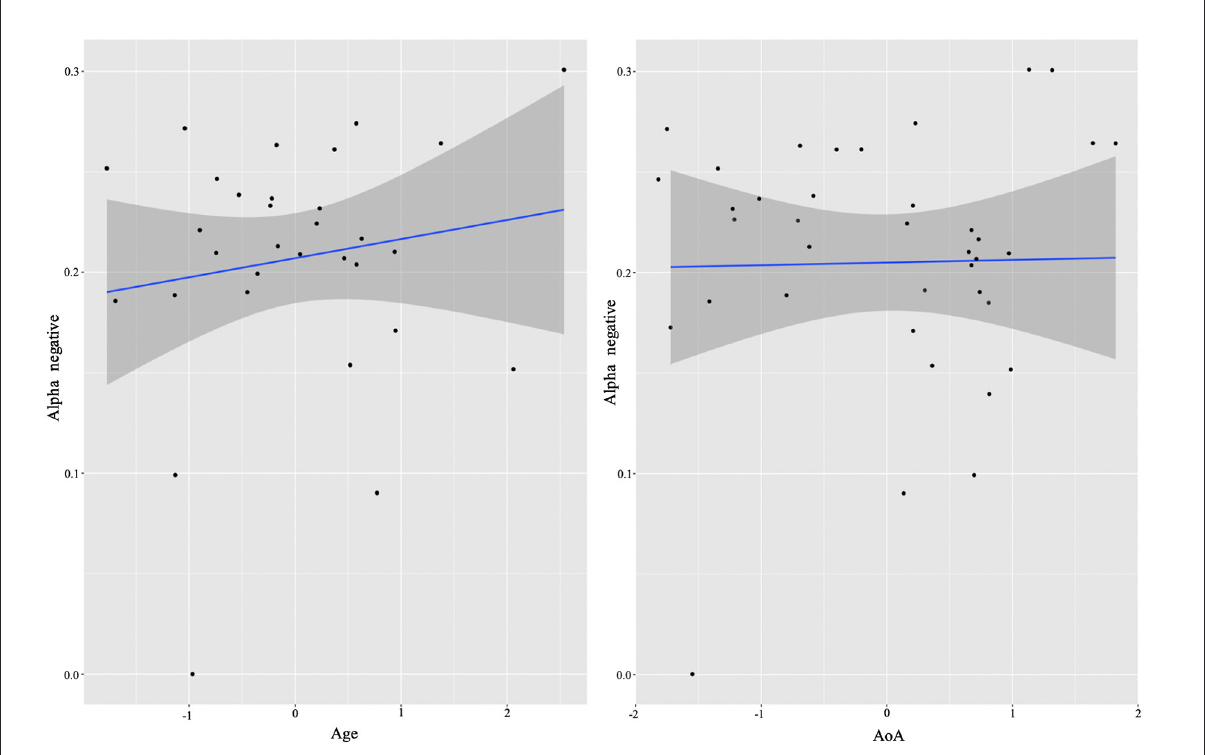
FIGURE4 L2 learner group individual analysis results in alpha. Predicted values of Age (left) and AoA onset (right) on alpha power (negative cluster) in the L2 learner group (see Section Identifying time-frequency clusters of interest for clusters of